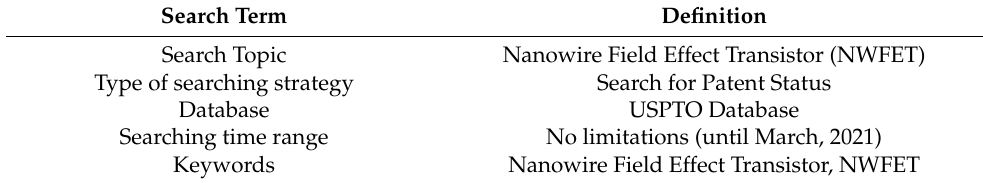
Table 6. Tech mining methods.